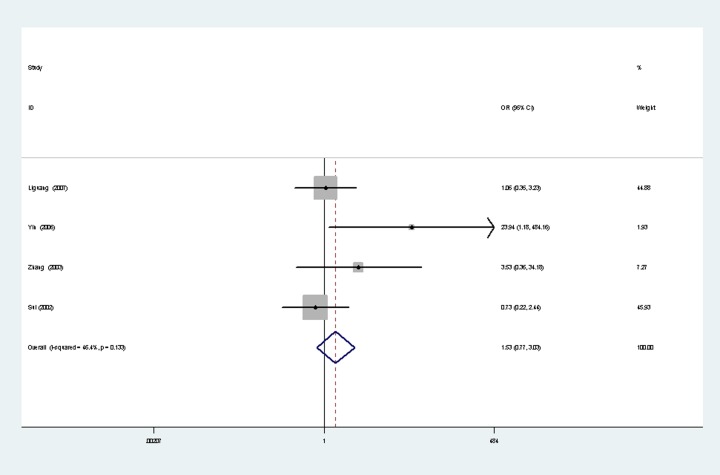
Lymphatic metastasis.